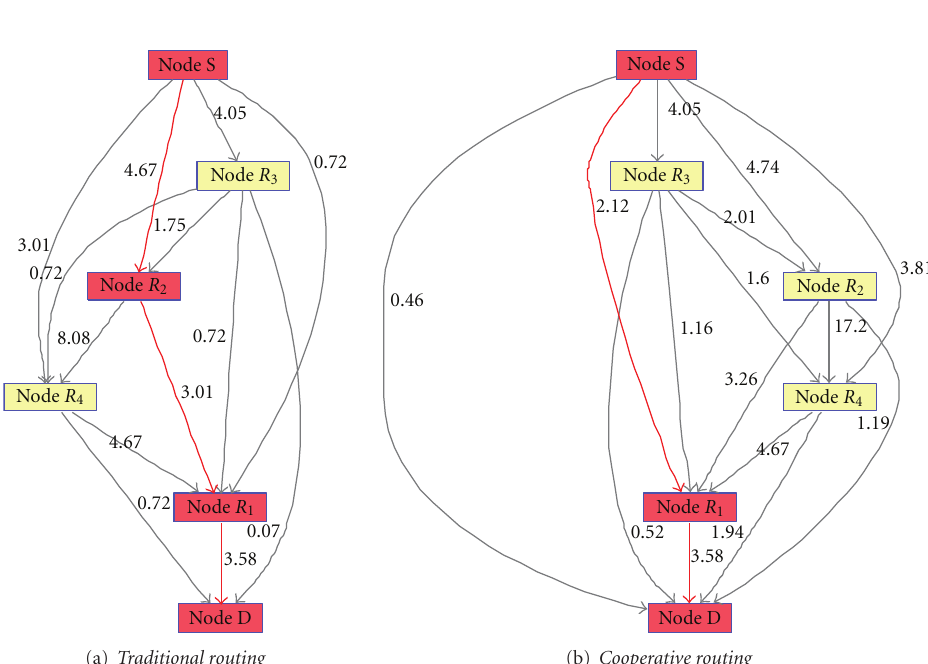
Figure 5: Route for highest packet delivery ratio.